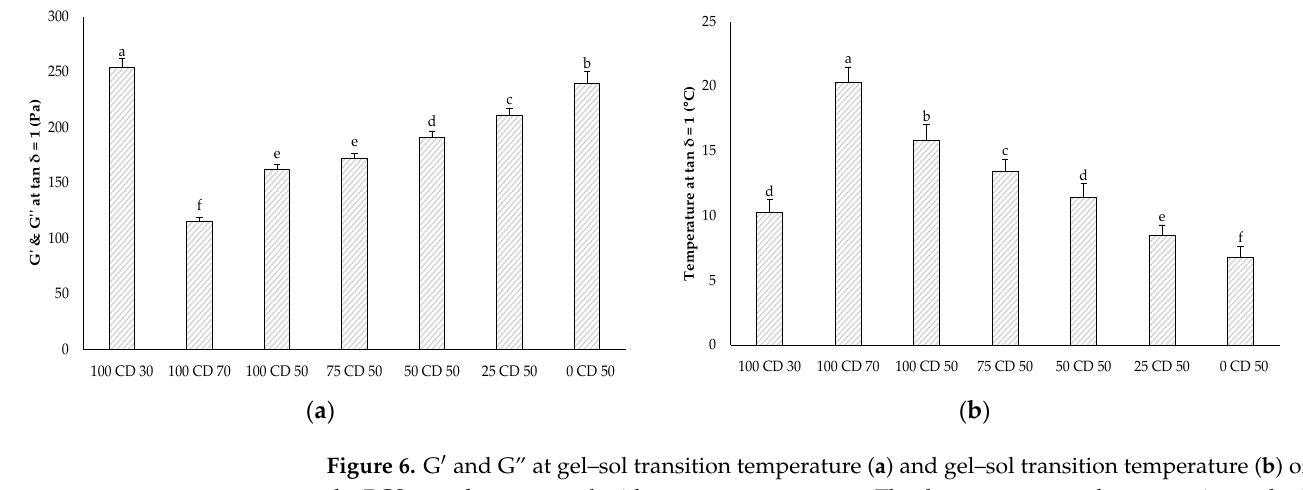
Figure 6. G ′ and G ″ at gel – sol transition temperature ( a ) and gel – sol transition temperature ( b ) of the PCS samples measured with a temperature sweep. The data are expressed as mean ± standard deviation ( n > 9). Bars with different letters indicate significant differences between samples ( p ≤ 0.05) following a one-way ANOVA (Tukey).